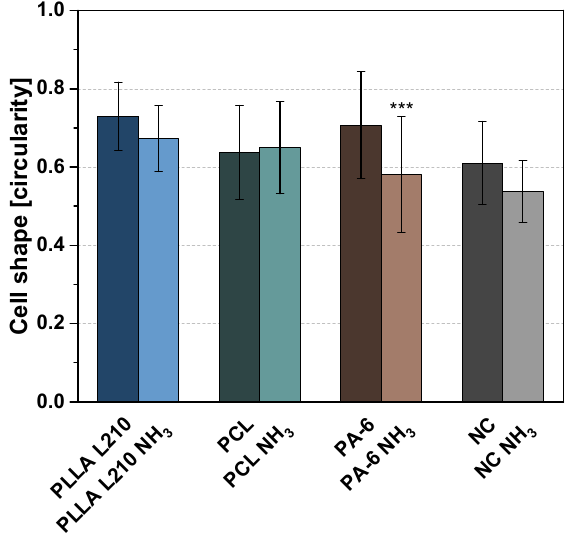
Figure 9. Cell shape described by cell circularity of human endothelial EA.hy926 cells on untreated and NH 3 -plasma functionalized polymeric nonwovens after 48 h (mean + SD, n = 40, one-way ANOVA, *** p < 0.001).